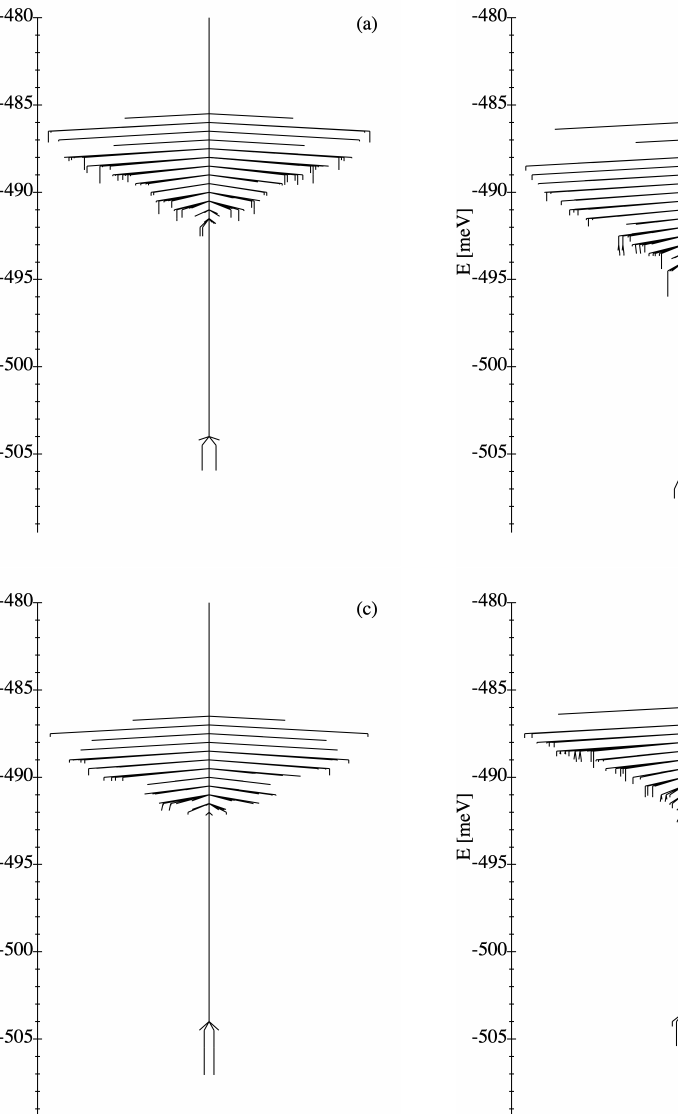
Figure 3. Disconnectivity graphs of the energy landscapes of the four weakly-disordered square lattice ensembles ( a – d ) illustrated in Figure 1. The two-fold degeneracy of all local minima is a known consequence of time-reversal